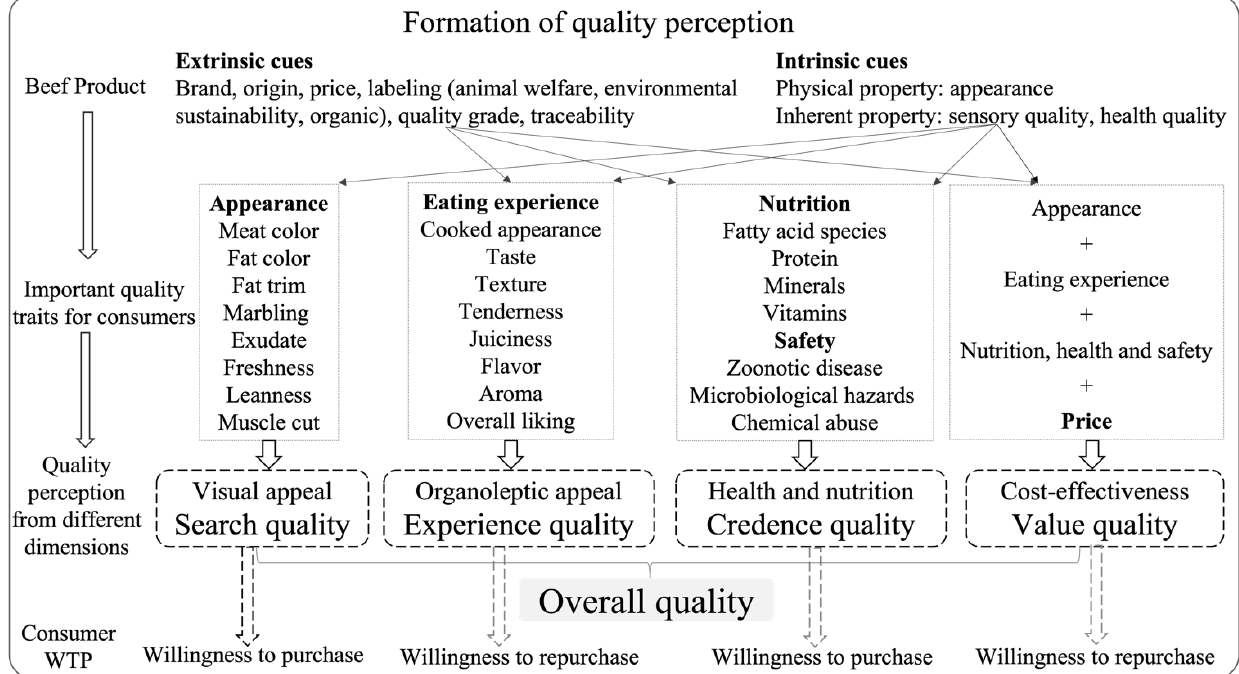
Figure 1. The formation of consumer beef quality perception.